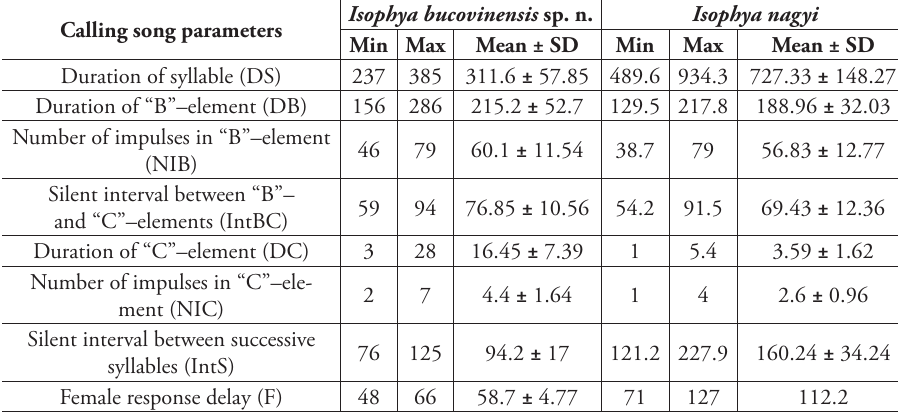
Table 2. Descriptive statistics for oscillographic parameters of the male calling song and for female re- sponse delay in Isophya bucovinensis sp. n. and I. nagyi (duration values in milliseconds). Number of speci- mens for which measurements were made: I. bucovinensis 11 males, 5 females; I. nagyi 10 males, 2 females.